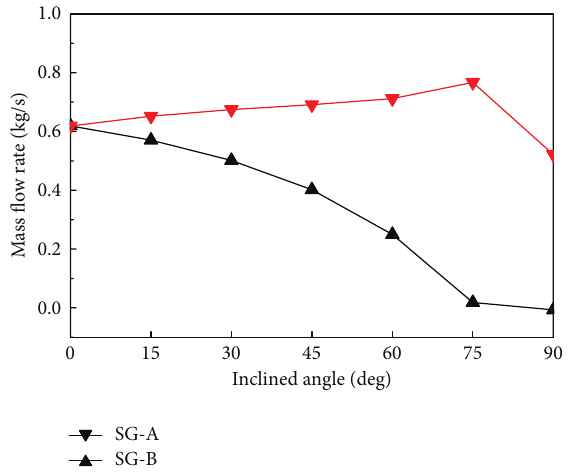
Figure 9: Branch mass flow rate variation with inclined angle.